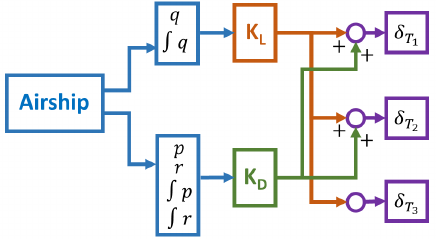
Figure 4. Stability augmentation logic for layout